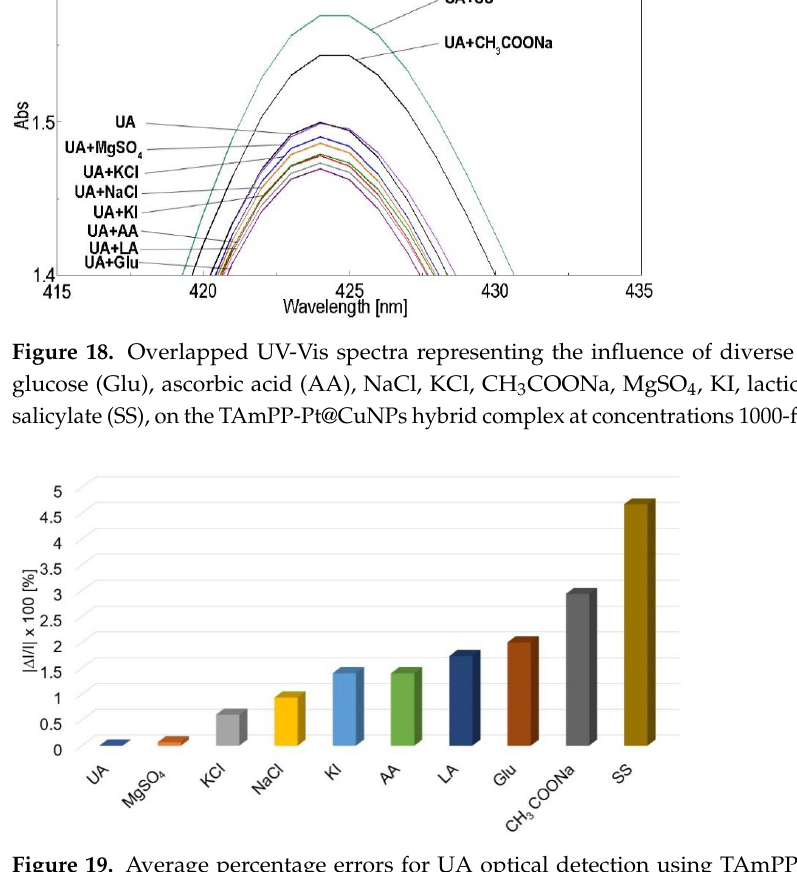
Figure 19. Average percentage errors for UA optical detection using TAmPP-Pt@CuNPs hybrid complex hybrid complex, introduced by different interferences.